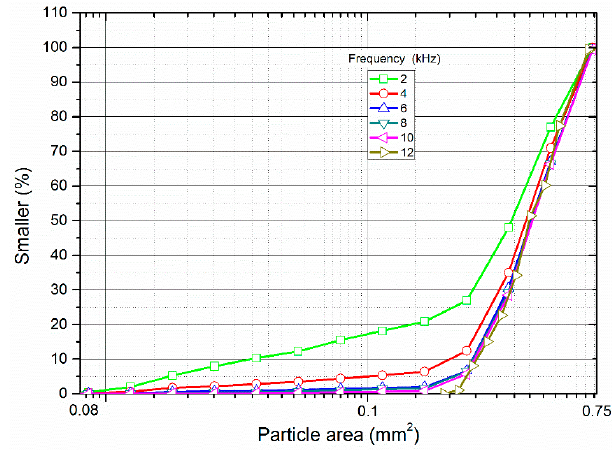
Figure 12. The particle area distribution of the filled particles after loading by stress waves with different frequencies.